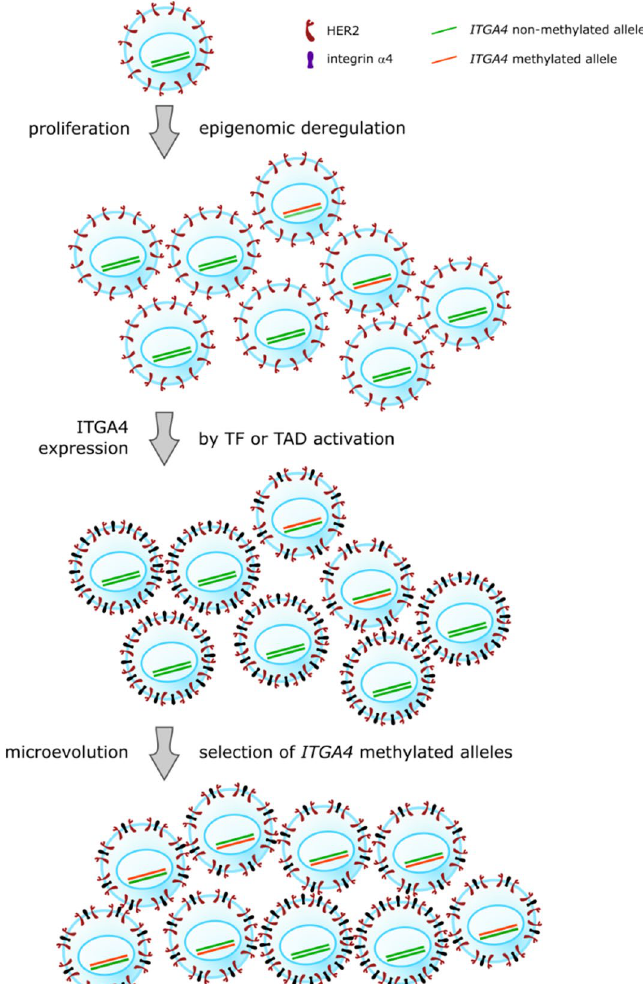
Figure 6. A hypothetical mechanism for the tumor microevolution advantage of the methylated ITGA4 gene promoter in HER2 positive breast tumors. The hypothesis is that co-expression of the HER2 and integrin α4 receptors might reduce microevolution fitness of cancer cells; “preventive prohibition” of the ITGA4 gene expression by its promoter methylation provides advantage for the cells in cases when under any circumstances the mechanisms of ITGA4 transcription in a tumor are activated (see detailed explanation in the text). TF, transcription factor; TAD, topologically associating